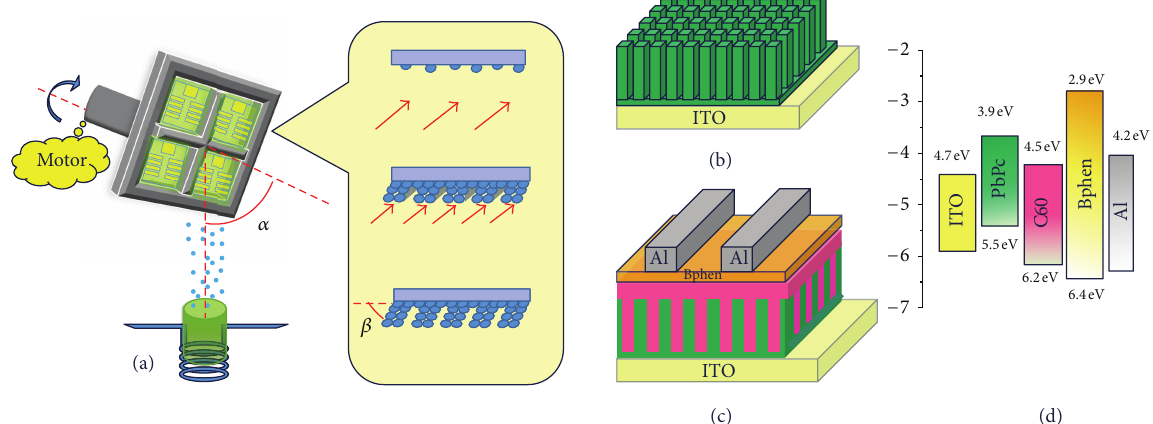
Figure 1: (a) Schematic diagram of GLAD installation, (b) schematic diagram of PbPc nanocolumn, (c) schematic OPV device architecture (ITO/PbPc/C 60 /Bphen/Al), and (d) energy level configuration of the used materials.